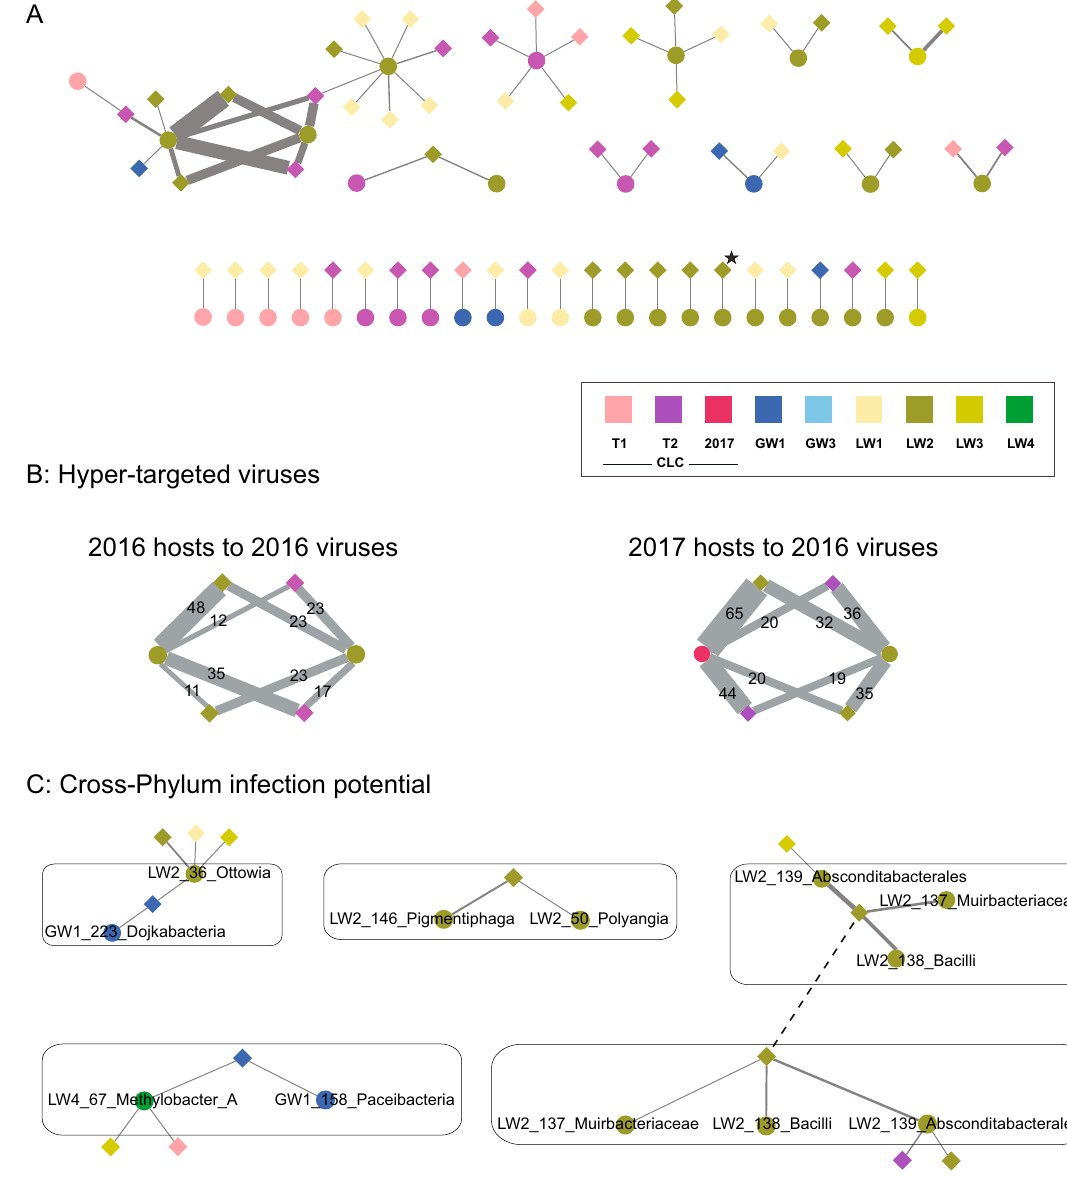
Figure 1. ( A ) Virus-host interactions in a Southern Ontario landfill mapping 2016 hosts and 2016 viruses. CRISPR array spacers from the MAGs (circles) were mapped against the viral elements (diamonds) predicted by VirSorter and VIBRANT to establish virus-host linkages (connecting edges). The network is colored by the geographic sampling location from which the MAG or viral element originated, with the width of the edges proportional to the number of spacer-protospacer matches supporting the connection. A viral element encoding a Diversity Generating Retroelement (DGR) 62 is denoted by a star. MAG identifier and lowest level of taxonomy as determined by GTDB-Tk 46 are noted in Supplemental Fig. S3. The other three networks are presented in full in Supplemental Figs. S4–S6. ( B ) Hyper-targeting dynamics between 2016 (left) and 2017 (right) hosts against the 2016 viral elements, with the number of spacer-protospacer matches supporting the connections. ( C ) Viral elements and hosts predicted to be involved in cross-phylum infections across all virus-host networks. The two viral elements connected by a dashed edge are predicted to be the same viral element in common between 2016 and